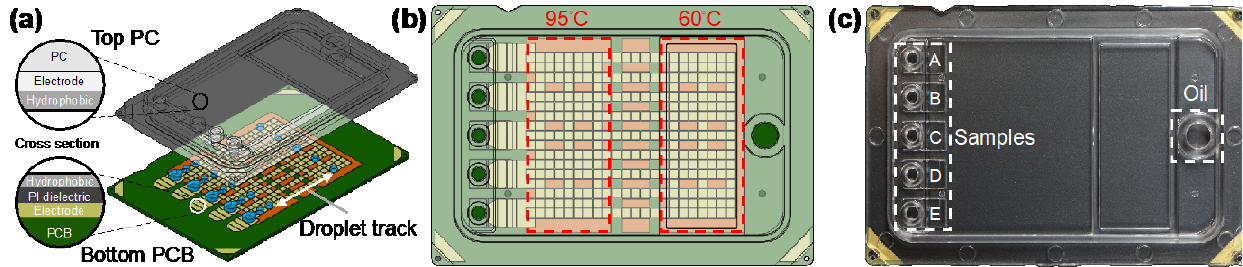
Figure 1. Digital microfluidic (DMF) cartridge for quantitative polymerase chain reaction of severe acute respiratory syndrome coronavirus 2 (qPCR SARS-CoV-2) testing. ( a ) Schematic illustration of the cartridge composed of top polycarbonate (PC) and bottom printed circuit board (PCB) plates with multiple droplet tracks. ( b ) The design of the driving and reservoir electrodes and two temperature zones designed to perform qPCR in the cartridge. ( c ) The assembled and packaged cartridge showing five inlets and reservoirs for samples and an inlet for oil.